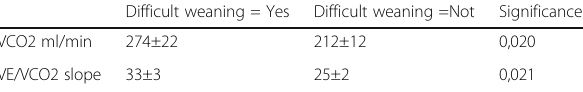
Table 1 (abstract 0150). Association between difficult weaning and physiological variables from volumetric